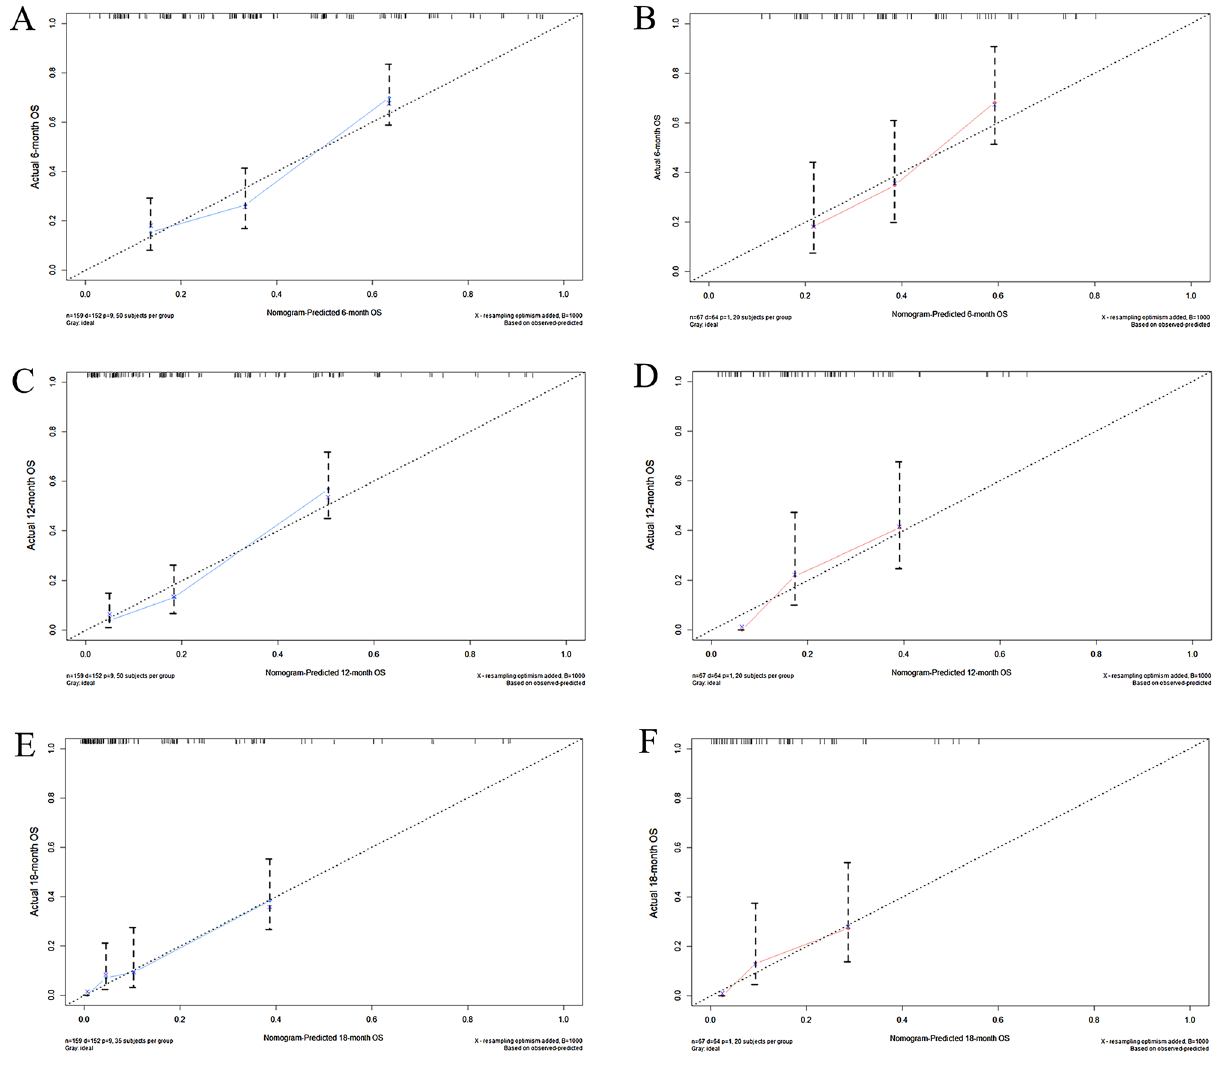
Figure 6. Calibration curves of 6-month in the training set ( A ); 12-month survival in the training set ( C ); 18-years survival in the training set ( E ); 6-month survival in the validation set ( B ); 12-month survival in the validation set ( D ); 18-years survival in the validation set ( F